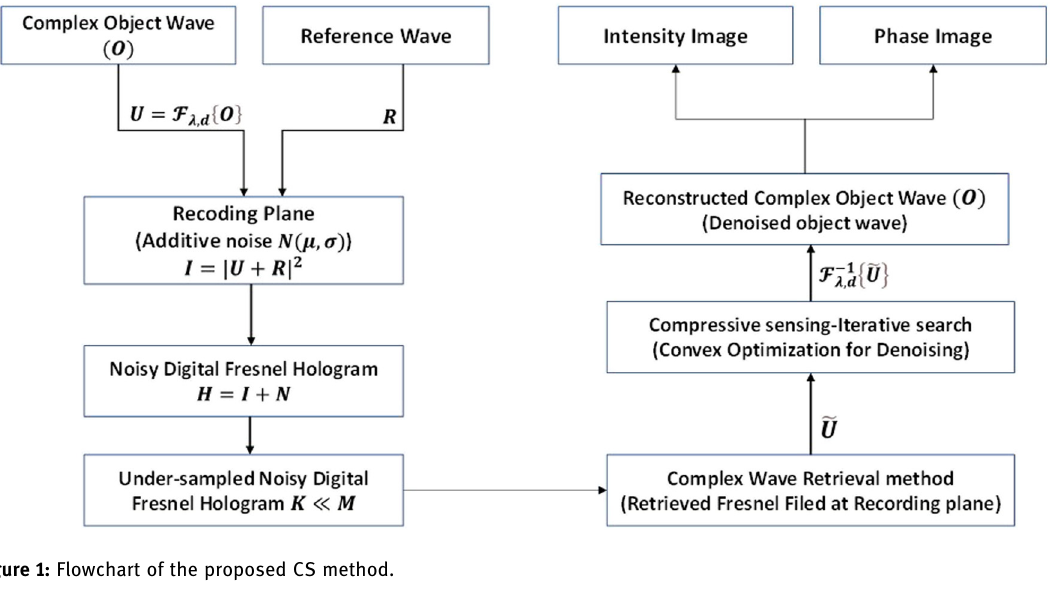
Figure 1: Flowchart of the proposed CS